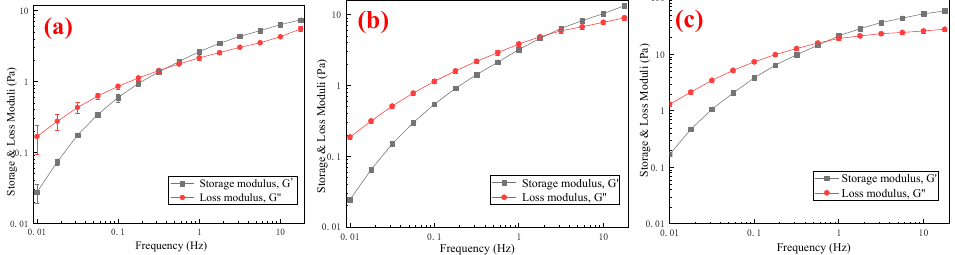
Figure 10. G’ and G” varying as a function of angular frequency for three polymers. ( a ) HGP, ( b ) GP-T, ( c ) HP-T. Table 1. Crossover frequencies and longest relaxation times of three polymer solutions.